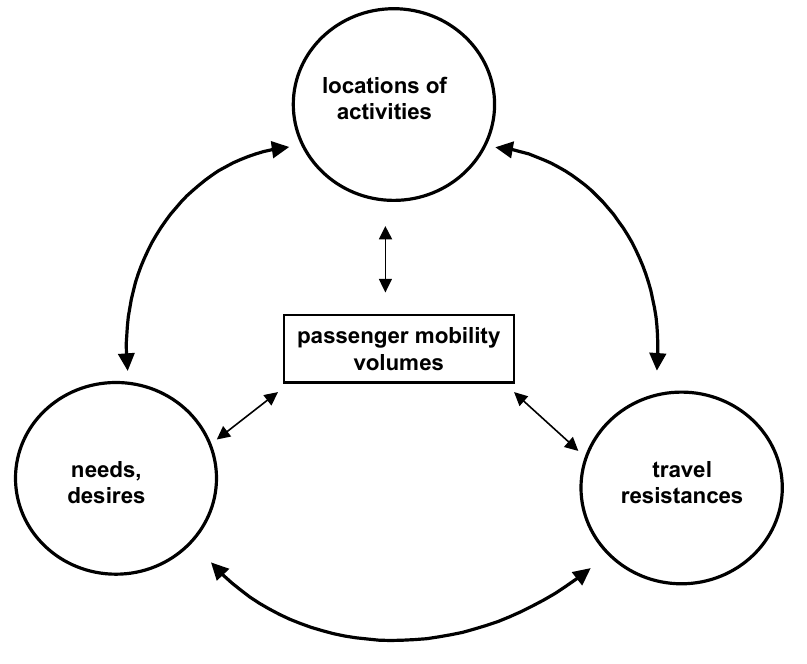
Figure 2.1 Relationships between activity locations, needs and desires, transport resistances and passenger